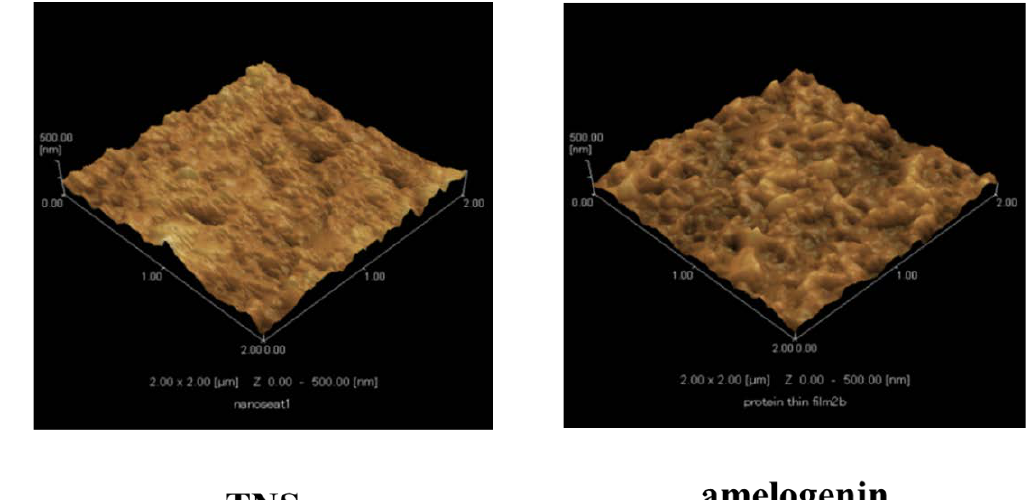
Figure 1. SEM micrographs of control and test groups.